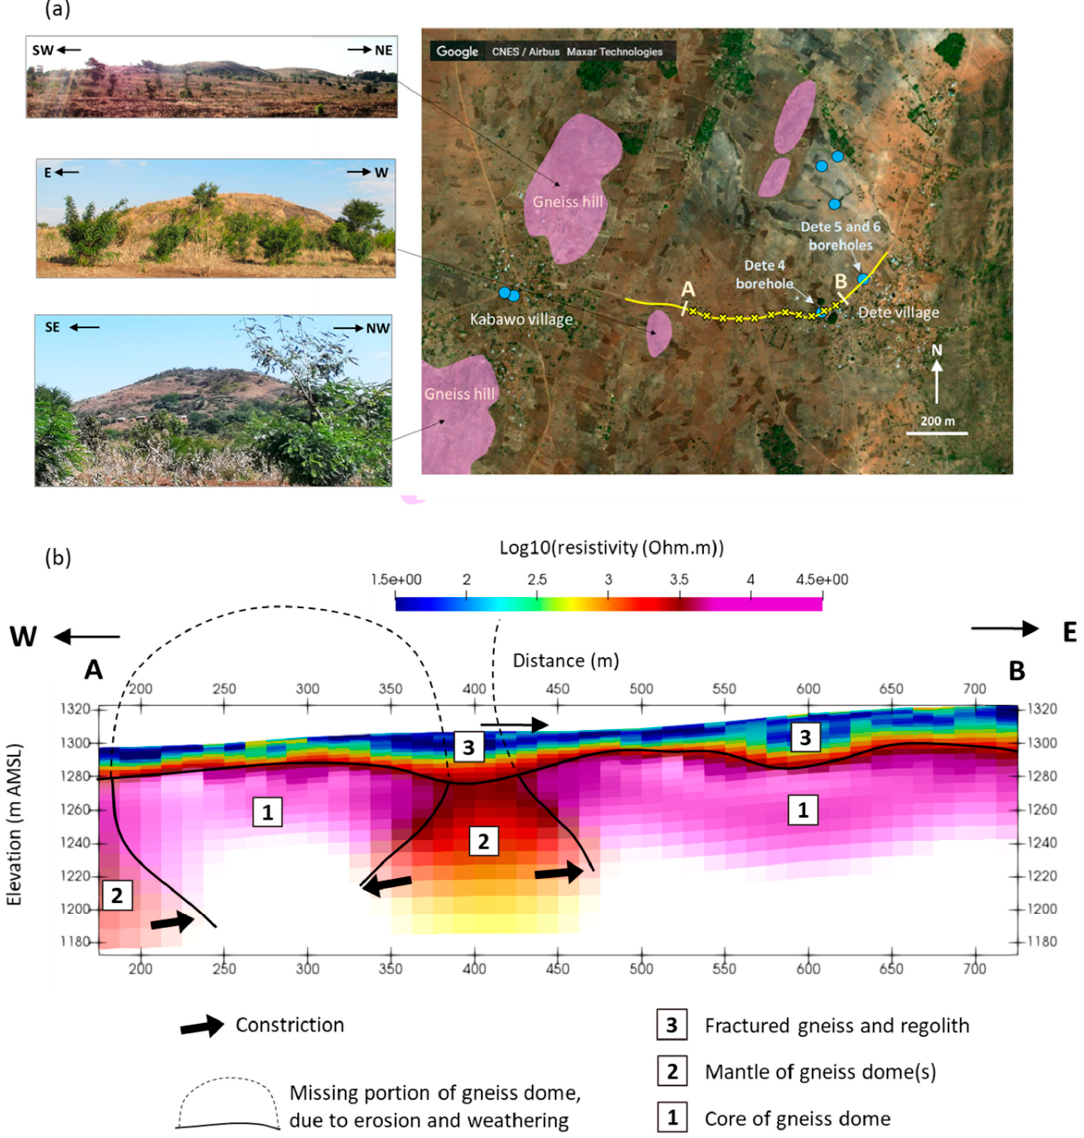
Figure 8. Dete survey: ( a ) site survey line location (with individual sounding mid-points marked as crosses) shown on a Google Earth satellite image (July 2020 download) of the area with accompanying landscape photographs; and ( b ) interpreted subsurface resistivity cross-section obtain for section line AB marked on ( a ).